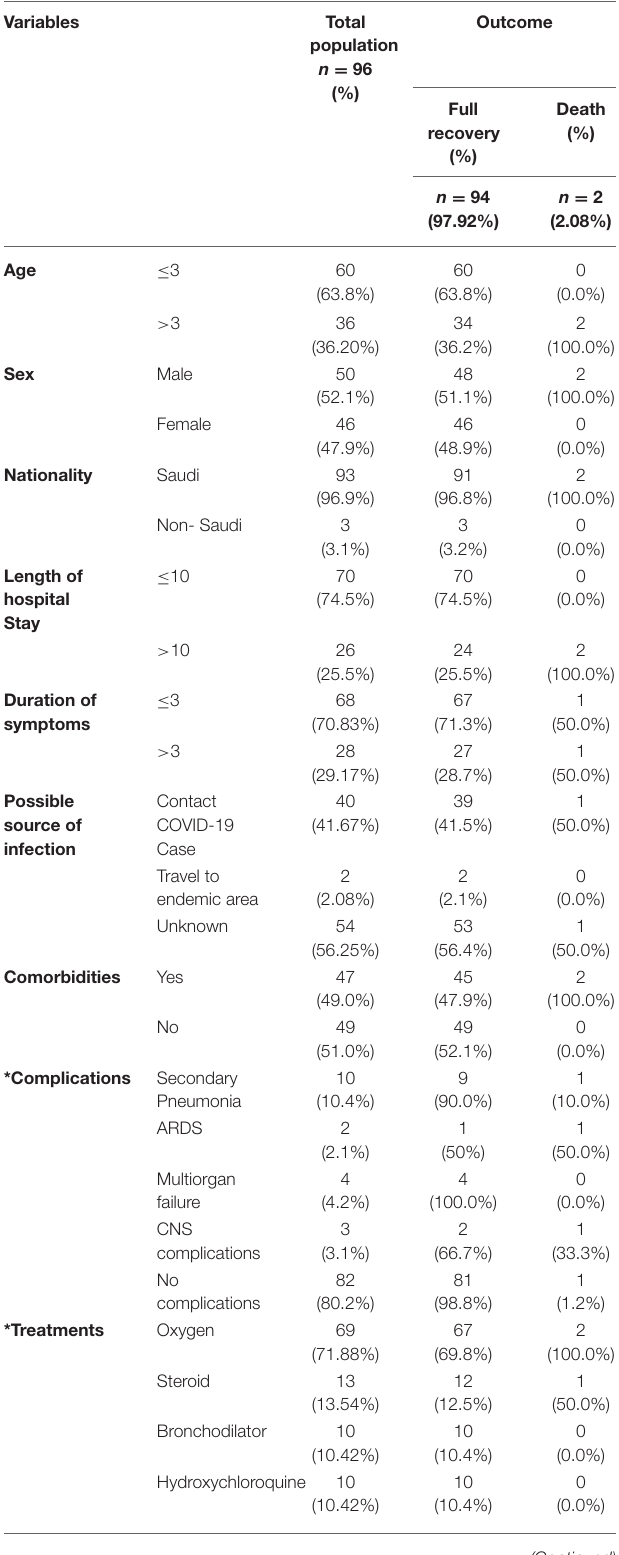
TABLE 1 | Patients demographics and disease characteristics associated with the outcome of children admitted with confirmed COVID-19 infection ( n =